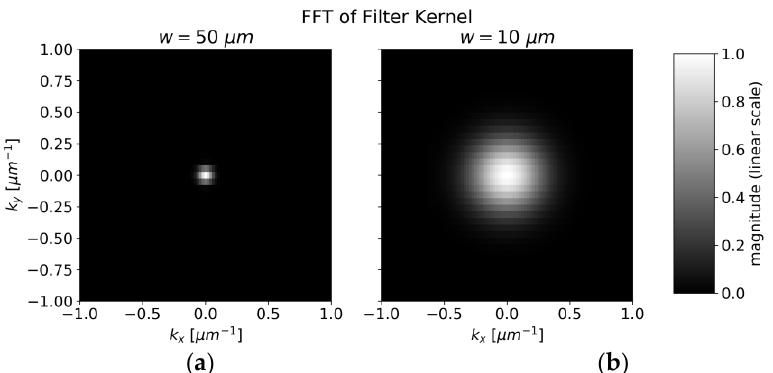
Figure 14. ( a ) Transfer function H(k x , k y ) for 50 µm waist size of the excitation beam. ( b ) Transfer function for 10 µm waist size.